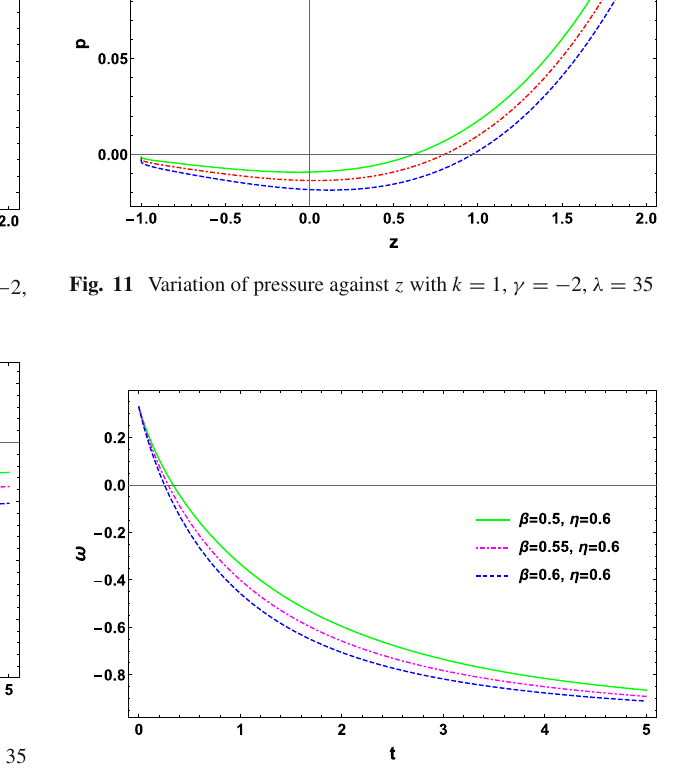
Fig. 12 Variation of EoS Parameter against time with k = 1, γ = − 2, λ =